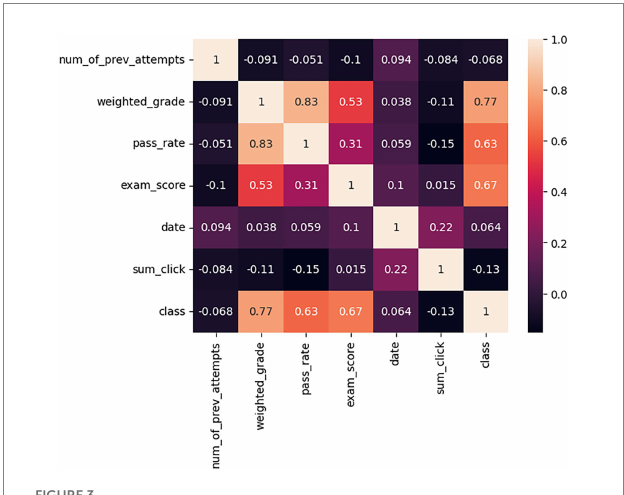
FIGURE 3 Spearman’s correlation coefficient: